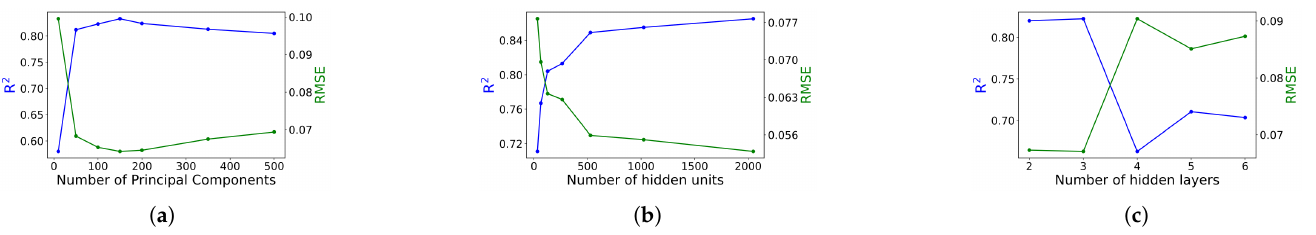
Figure 10. Variation of ( a ) R 2 and RMSE for selection of principal components, ( b ) R 2 and RMSE as a function of number of hidden units, ( c ) R 2 and RMSE as a function of number of hidden layers in NN.